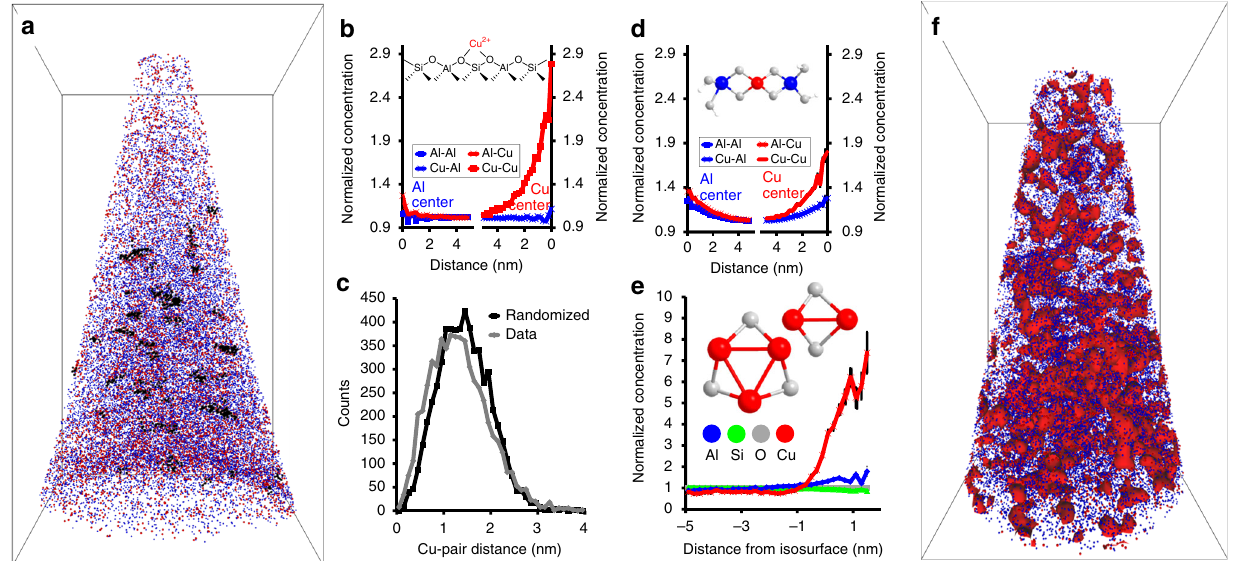
Fig. 3 Overview of atom probe tomography results for fresh and aged Cu-SSZ-13. a Reconstructed needle of fresh Cu-SSZ-13 ( 4 , full results are in Supplementary Fig. 28) with Cu (red) and Al (blue) ions shown with Cu clusters overlaid in black, this is also included as Supplementary Movies 4 and 5. Bonding box dimensions are 63 × 67 × 115 nm 3 . b Radial distribution functions (RDFs) in fresh Cu-SSZ-13 for Al and Cu centers. Al – Cu af fi nity is indicated, which would be expected due to Cu exchanging onto paired Al sites, as indicated in the schematic. c Nearest neighbor distribution for fresh Cu-SSZ-13 for Cu showing a signi fi cant deviation from a random distribution and indicating the presence of Cu clusters. d RDFs in aged Cu-SSZ-13 ( 6 , full results are in Supplementary Fig. 32) for Al and Cu centers. Strong af fi nities are indicated between all species, pointing to the migration and aggregation of Cu with aging, and a Cu aluminate species is shown, though it was not quantitatively identi fi ed. e Normalized compositional histogram across 1.4% Cu isoconcentration surfaces in aged Cu-SSZ-13, with potential CuO species shown. f Reconstructed needle of aged Cu-SSZ-13 ( 6 ) with 1.4% Cu isoconcentration surfaces shown, this is also included as Supplementary Movies 8 and 9. Bonding box dimensions are 49 × 52 × 90 nm 3 . All error bars were calculated from counting statistics using the method described in ref.